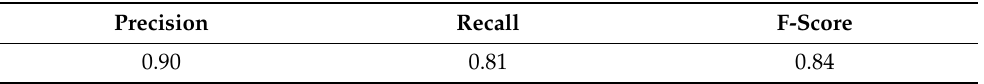
Table 8. Performance reported in [9] for concatenate convolutional neural networks applied to six classes of devices in BLUED dataset.